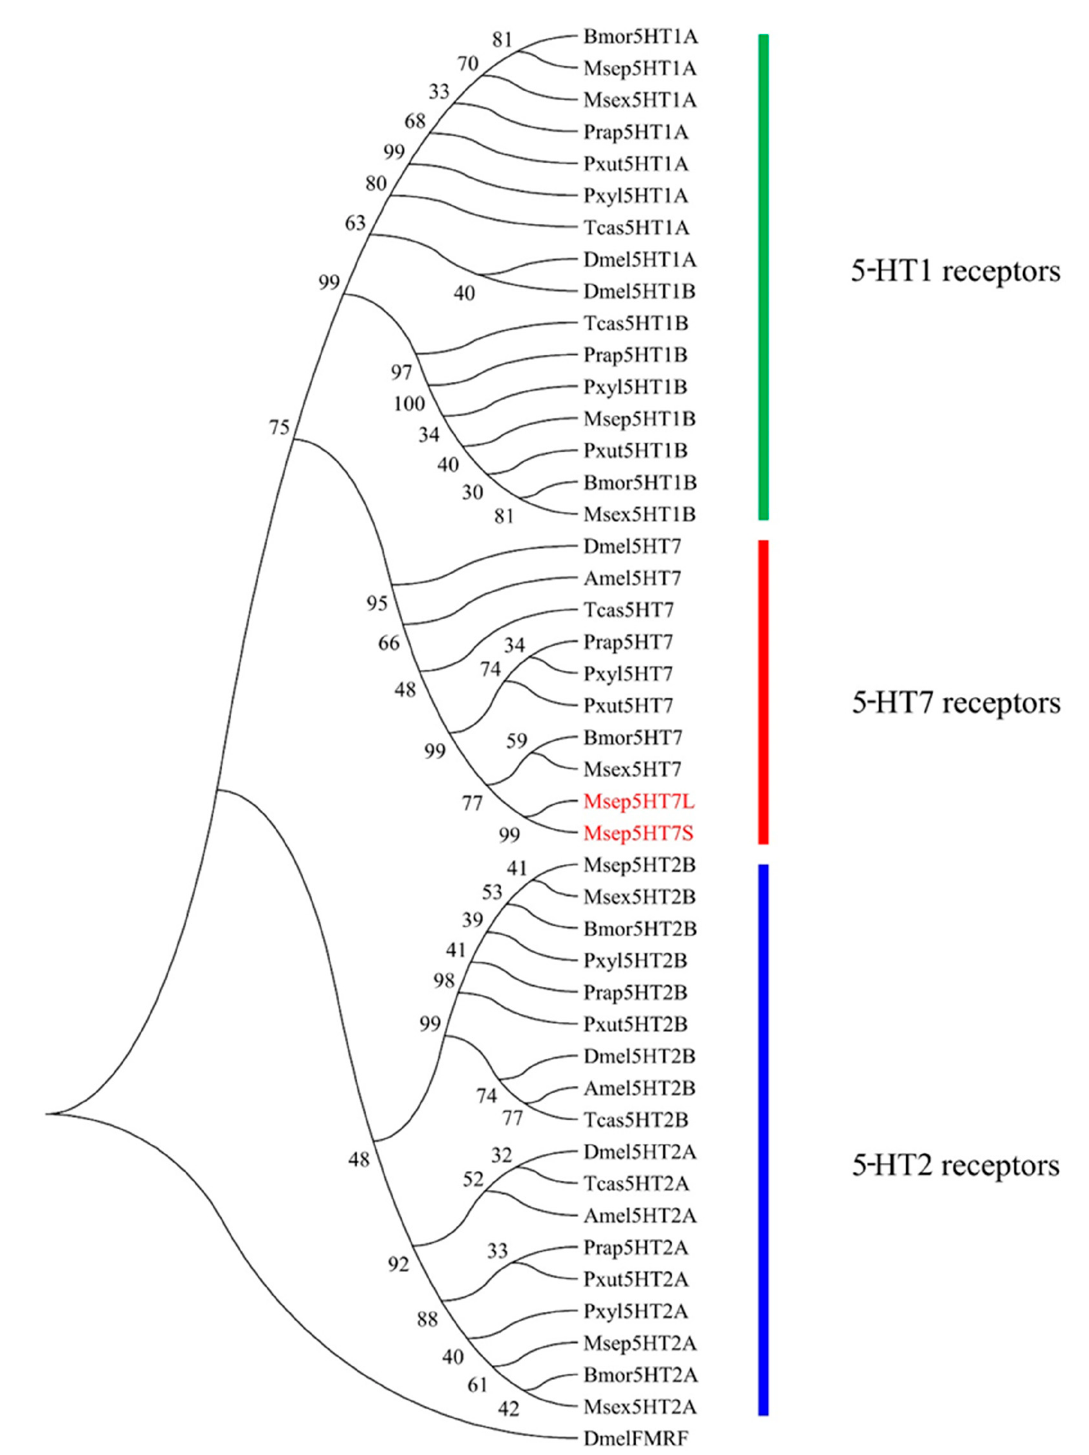
Figure 2. Phylogenetic analysis of two Msep5-HT7 receptor isoforms and various 5-HT receptors from other insects. Phylogenetic tree was constructed by MEGA6.0 with 1000-fold bootstrap re-sampling based on alignment results of MAFFT. FMRF amide receptor (DmelFMRF) of Drosophila melanogaster was used as outgroup. Bmor, Bombyx mori ; Msep, Mythimna separata ; Pxyl, Plutella xylostella ; Prap, Pieris rapae ; Pxut, Papilio xuthus ; Msex, Manduca sexta ; Dmel, Drosophila melanogaster ; Amel, Apis mellifera ; Tcas, Tribolium castaneum .